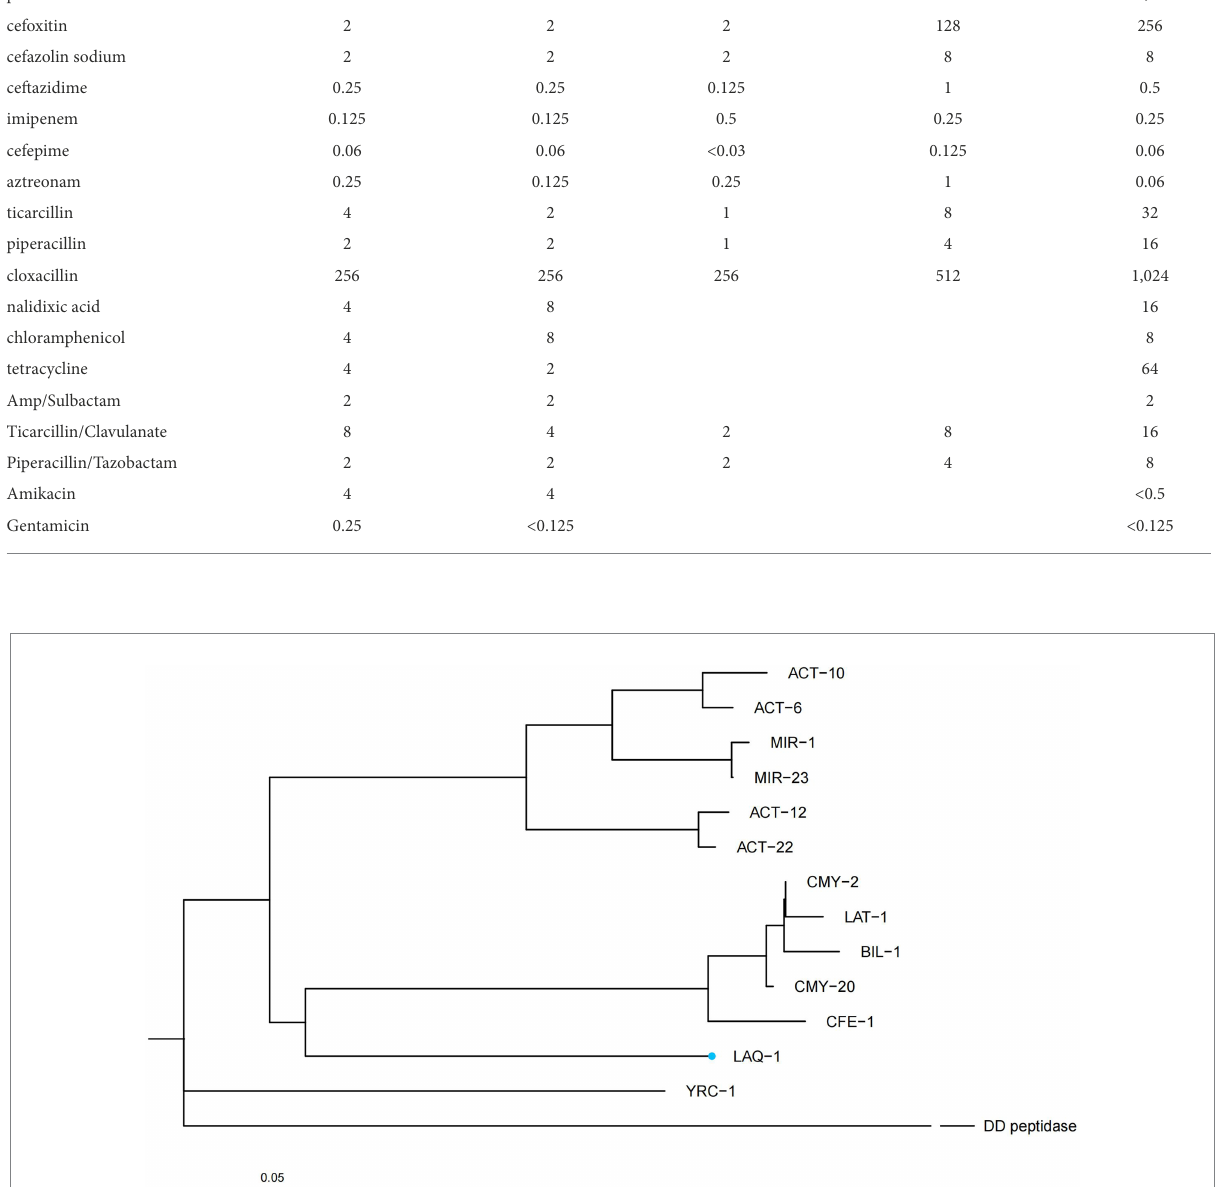
CMY-2, ACT-10, CMY-4, CMY-18 and ACT-10, respectively (Figure 3). Notably, all of these deduced amino acid sequences had the obligatory serine-active site of the β -lactamase catalytic motif S-X-S-K (serine-valine-serine-lysine) at positions 83–86, the typical